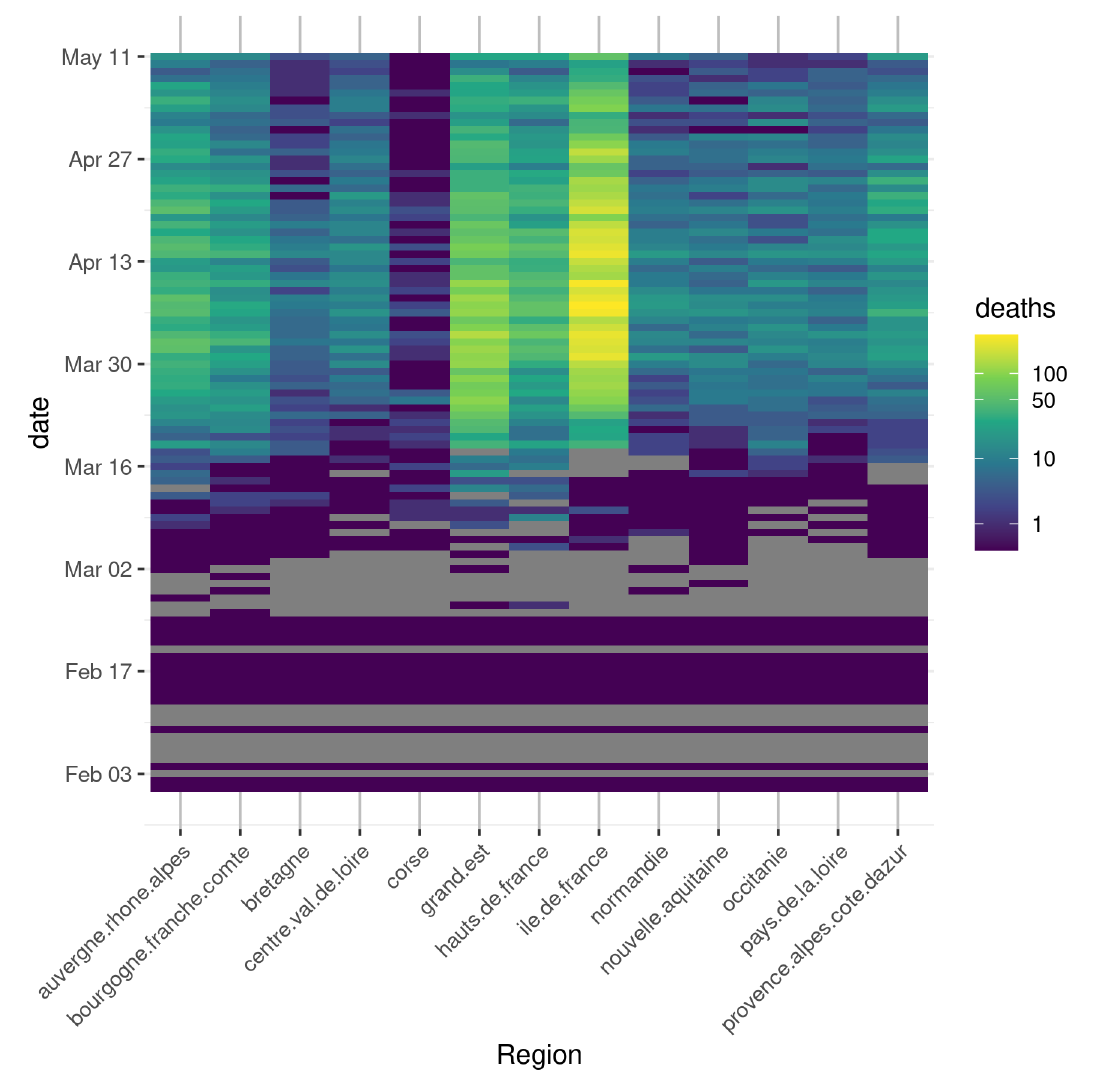
Figure 1 – Mortality data for 13 regions in France, from the first day when all regions have data. Colors are scaled as log mortality for a given day and region. Gray tiles indicate missing data. All data from March 19th onwards originate from the SPF